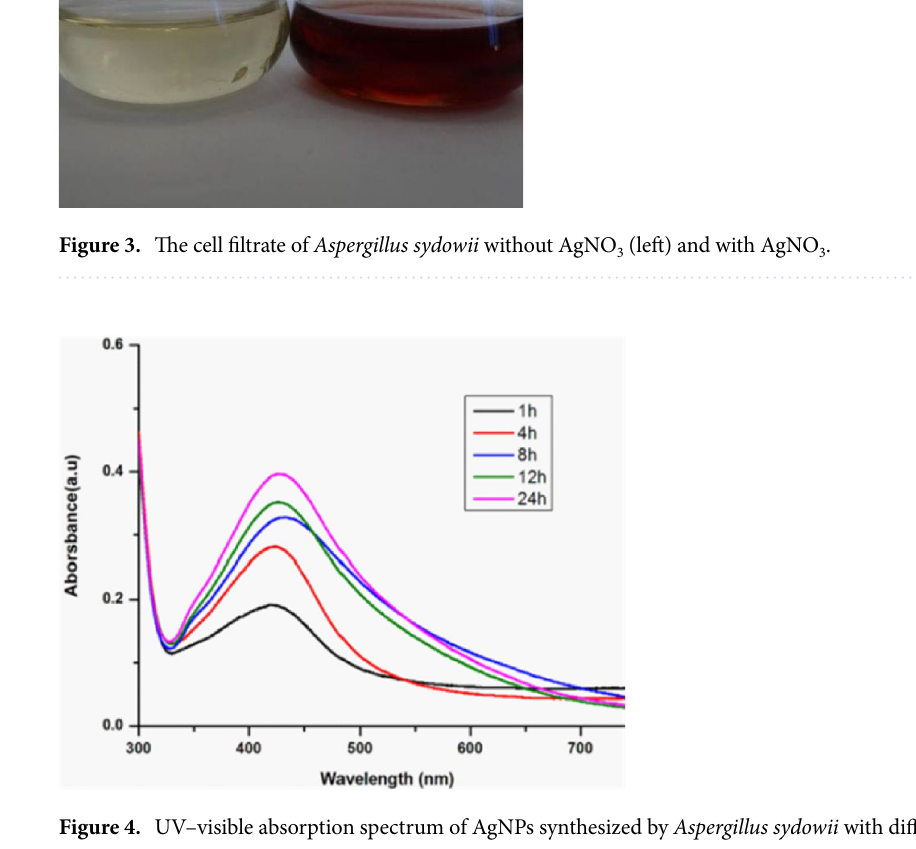
Figure 4. UV–visible absorption spectrum of AgNPs synthesized by Aspergillus sydowii with different time.